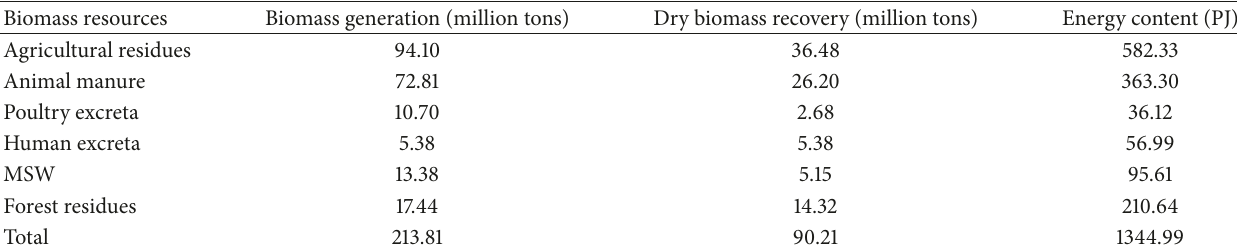
Table 2: Bioenergy potential in Bangladesh, 2012-2013